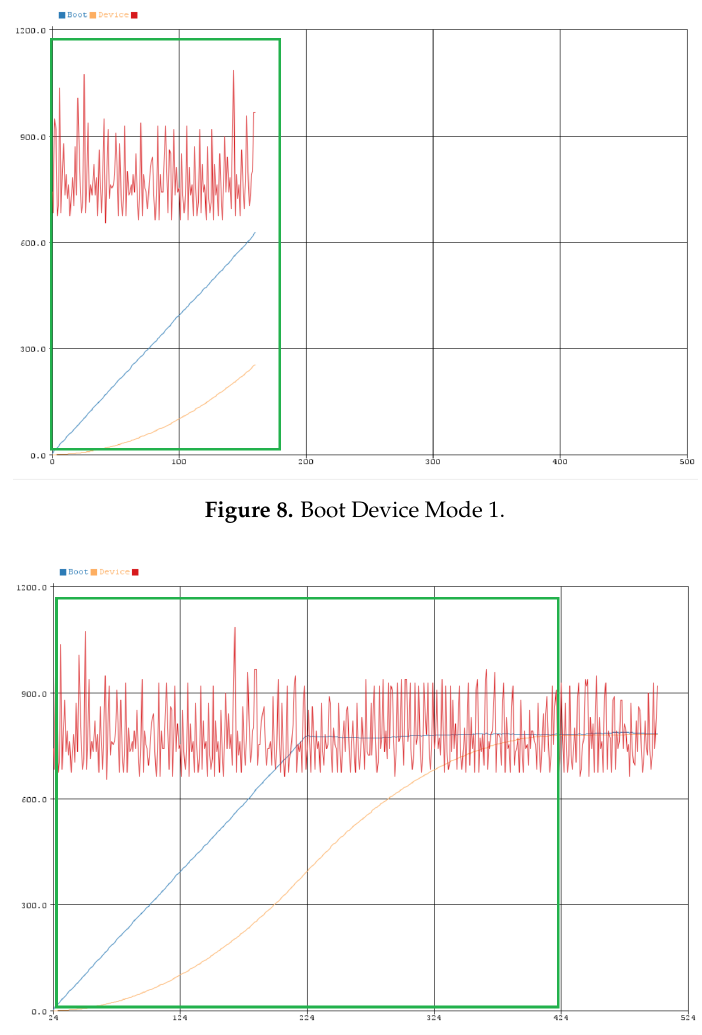
Figure 9. Boot Device Mode